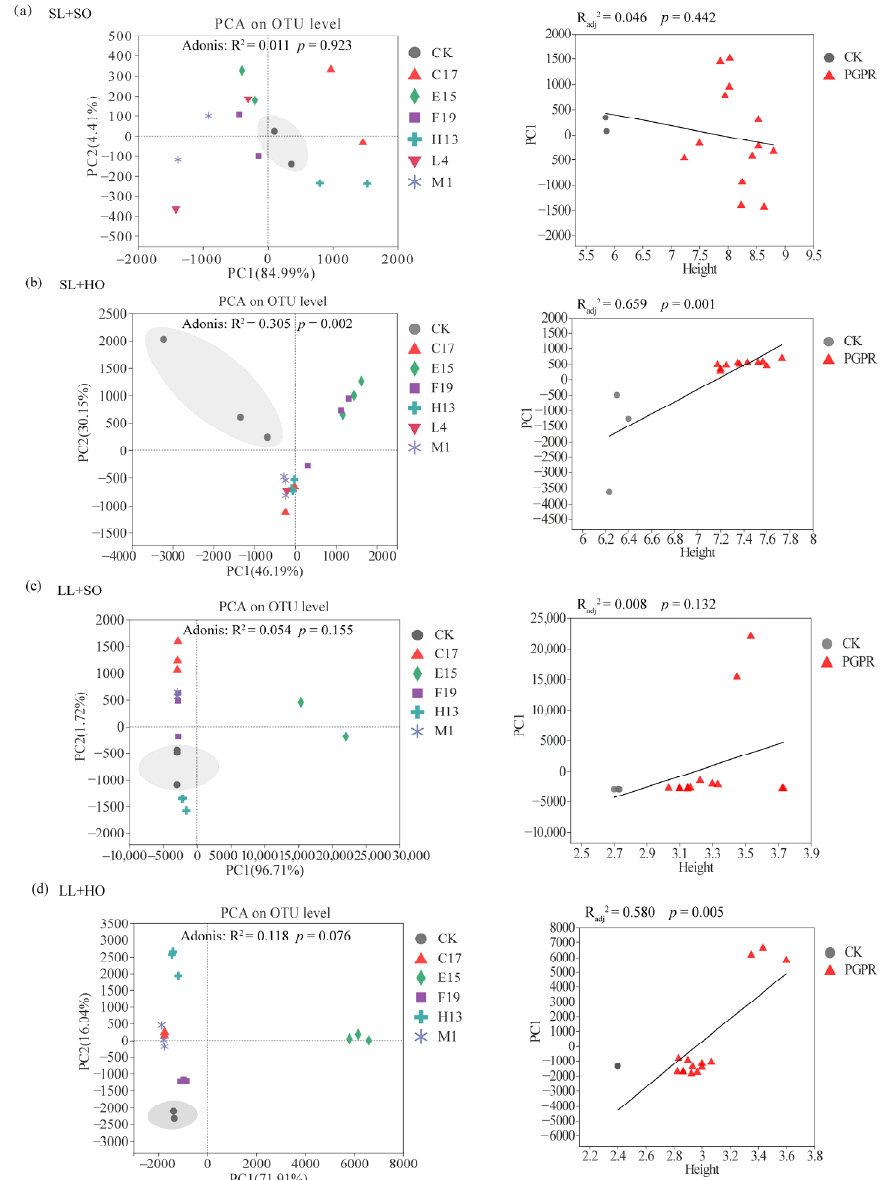
Figure 4. Principal component analysis (PCA) of the structure of bacterial communities and the correlations with shoot height of V. natans under four stress conditions; ( a ) Suitable light intensity and suitable sediment organic matter load (SL + SO); ( b ) Suitable light intensity and high sediment organic matter load (SL + HO); ( c ) Low light intensity and suitable sediment organic matter load (LL + SO); ( d ) Low light intensity and high sediment organic matter load (LL + HO). The gray circle is marked as the control group without bacteria addition, and the PGPR-inoculated group is outside the circle. Adonis was used to analyze the differences between the two groups: the non-inoculated control and the PGPR-inoculated group. Three replicates of each treatment were used for bacterial 16S rRNA gene profiling.